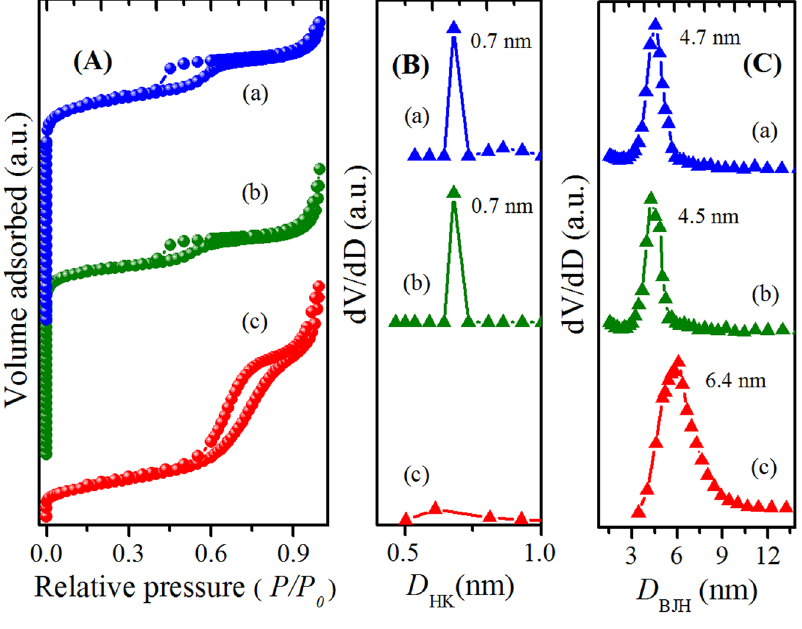
Figure 4. N 2 sorption isotherms ( A ), micropore ( B ) and mesopore ( C ) size distributions of: (a) ZH-Y; (b) ZH-X; (c)